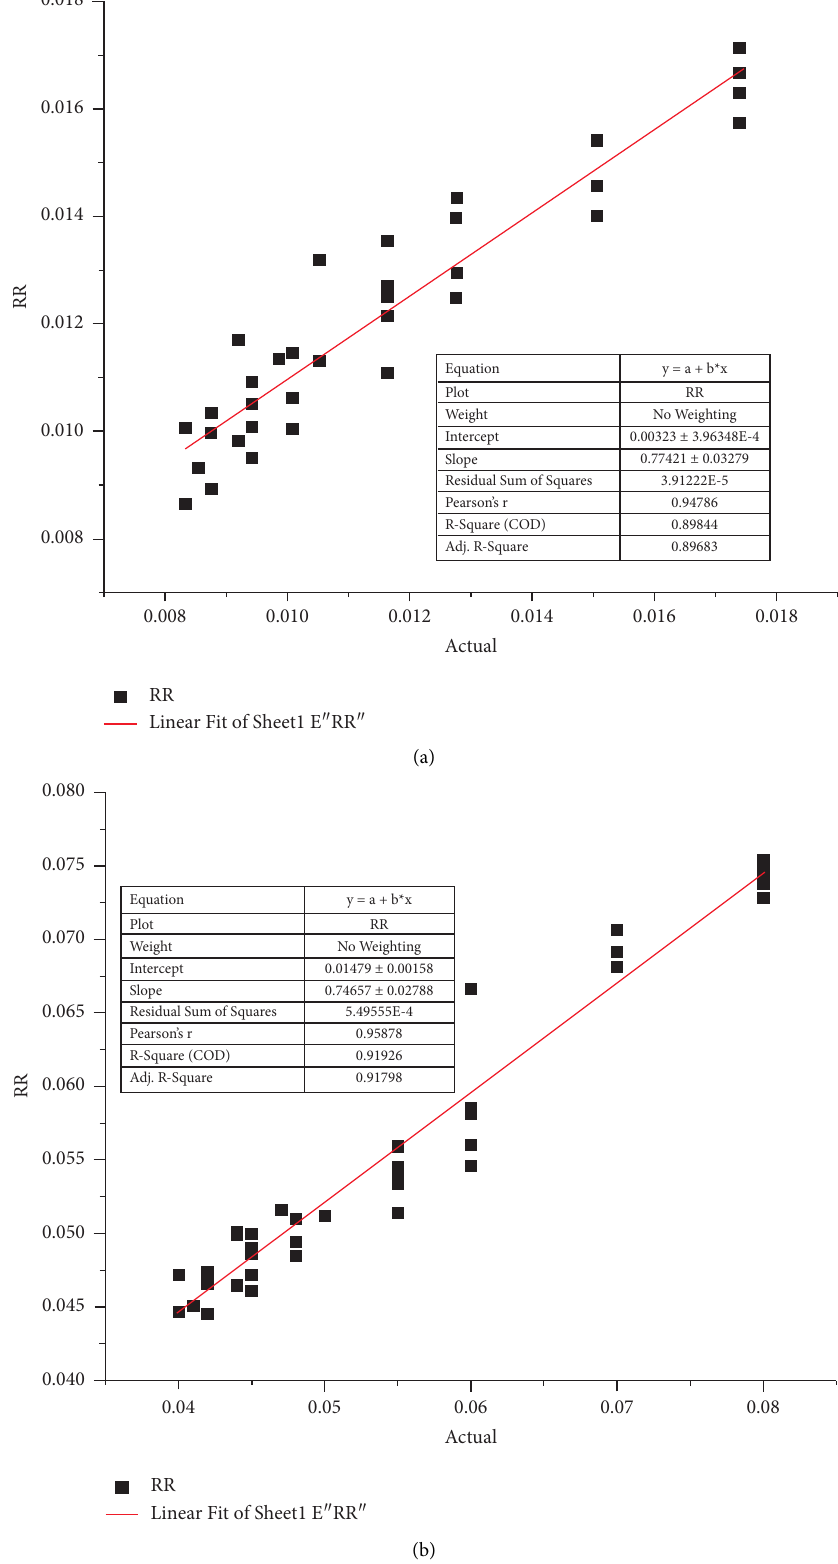
Figure 9: Te Ridge regression model scatter plots for the testing phase of the gas fow: (a) fracture porosity in oil system and (b) fracture